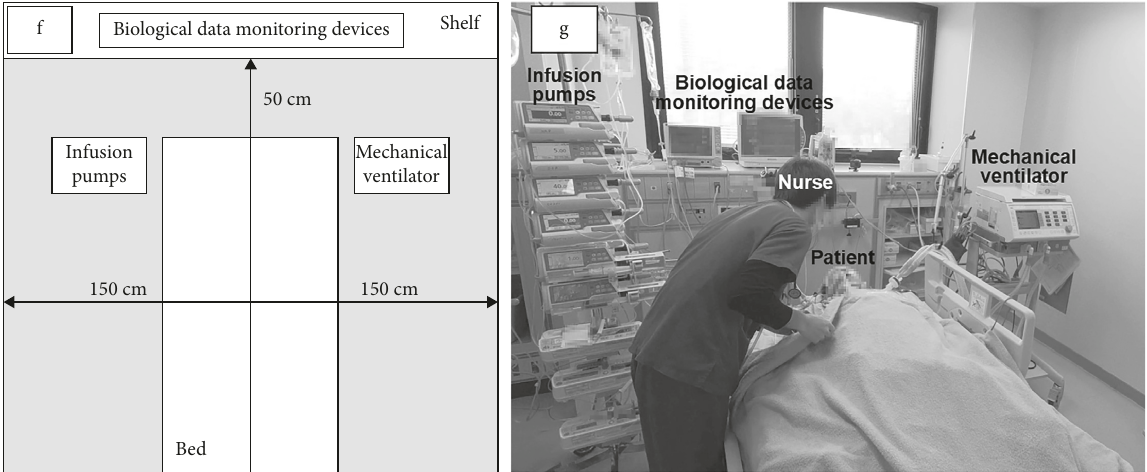
Figure 3: Conversation Area of the Patient (CAP). (f) Schematic of CAP. (g) Photograph of